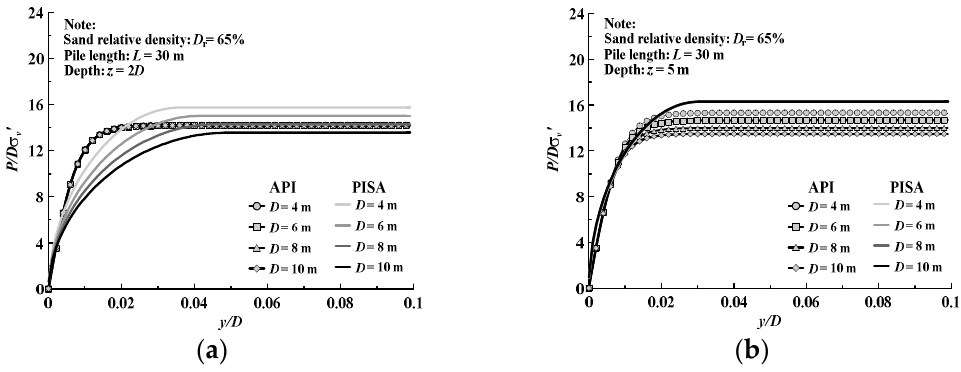
Figure 1. Typical p-y curves of API [21] and Burd et al. [25] at: ( a ) z = 2 D , ( b ) z = 5 m.